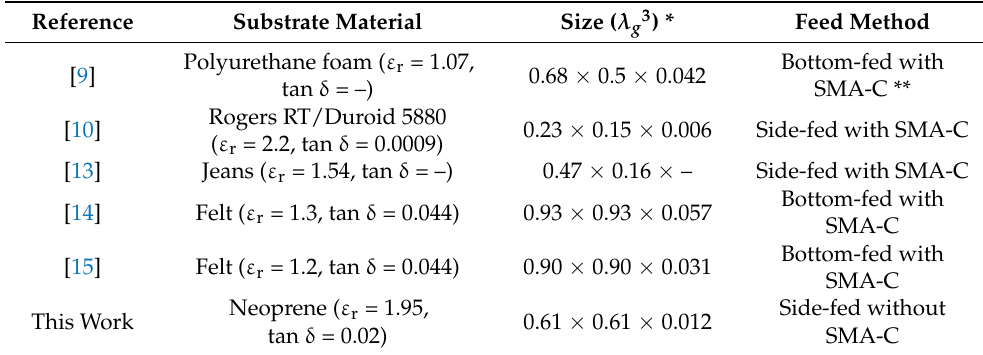
Table 1. Comparison of Dual-Band Wearable